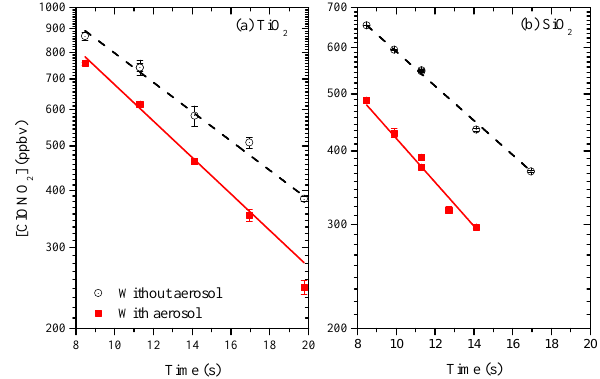
Figure 4. Decays of ClONO 2 in the aerosol flow tube without (open circles) and with (solid squares) aerosol particles in the aerosol flow tube under different experimental conditions. (a) TiO 2 with a surface area concentration of 2.3 × 10 − 3 cm 2 cm − 3 at 33%RH; (b) SiO 2 with a surface area concentration of 2.9 × 10 − 3 cm 2 cm − 3 at